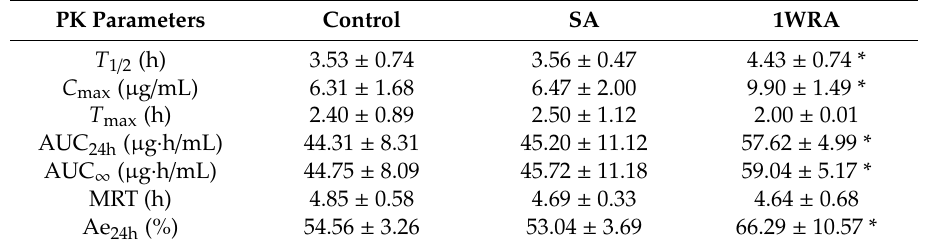
Table 3. Pharmacokinetic parameters of metformin in control, single oral administration (SA), and 1-week repeated administration (1WRA) of RGE (1.5 g / kg / day) following oral administration of metformin at a dose of 50 mg / kg in